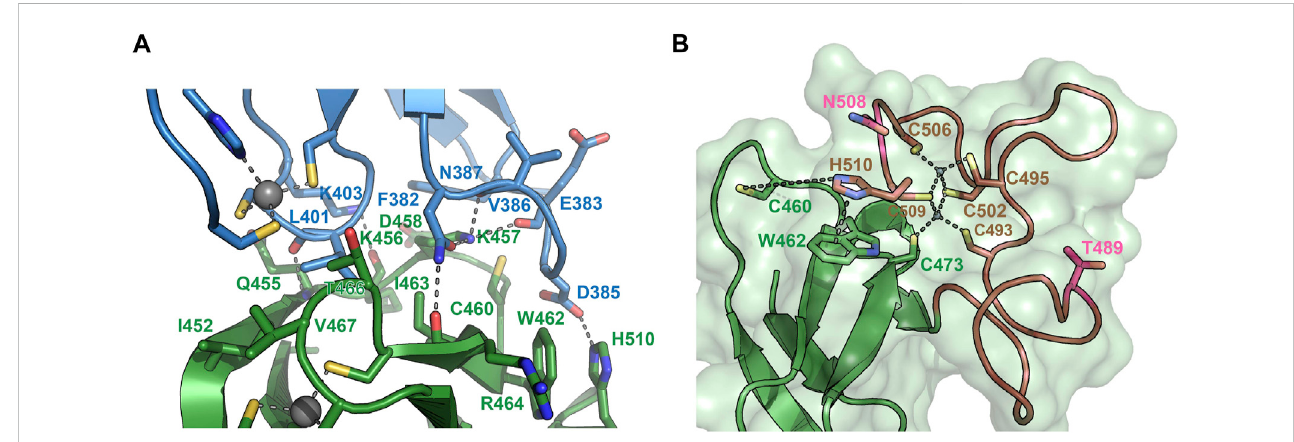
FIGURE 3 Structural details of the HOIL-1 IBR-RING2 architecture. (A) Close-up view of the interface between the IBR domain (blue) and the RING2 domain (green). Residues involved in IBR-RING2 interactions are shown as sticks. The catalytic cysteine (C460) protrudes into a groove of the IBR surface. Polar interactions are shown as dashed lines. The cut-off distance for polar and hydrophobic interactions is 3.5 and 4 Å, respectively. (B) Close-up view of the C-terminalloopregionofRING2whichformthebinuclearZinc-cluster(brown).Zinccoordinatinginteractionswithcysteinesareshownasdashedlines. The pi-stackinginteraction betweenH501and W462is shown as dashed line.The distancebetween H510 and thecatalytic cysteine 460 is7.6 Å.Positionsfor pathogenic variants of HOIL-1 (Thr489Profs*9 and Asn508Profs*4) in patients with polyglucosan storage disorders 489 and 508 are shown in pink.